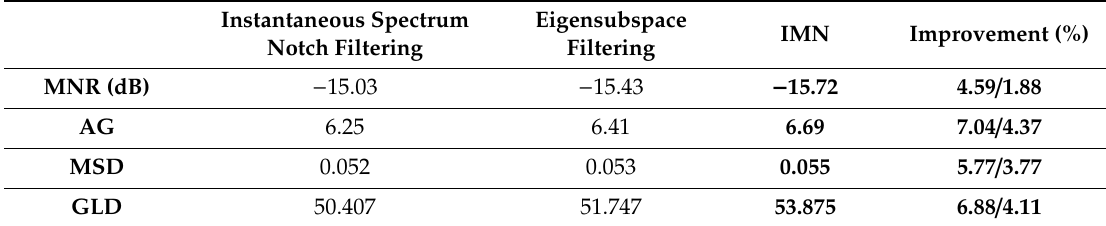
Figure 17. Mitigation results. ( a ) The SAR image without interference mitigation, ( b ) the SAR image after applying the instantaneous-spectrum notch filtering, ( c ) the SAR image after applying the eigensubspace filtering, and ( d ) the SAR image after applying the IMN. Table 6. SAR image quality evaluation for the measured WBI-contaminated data.